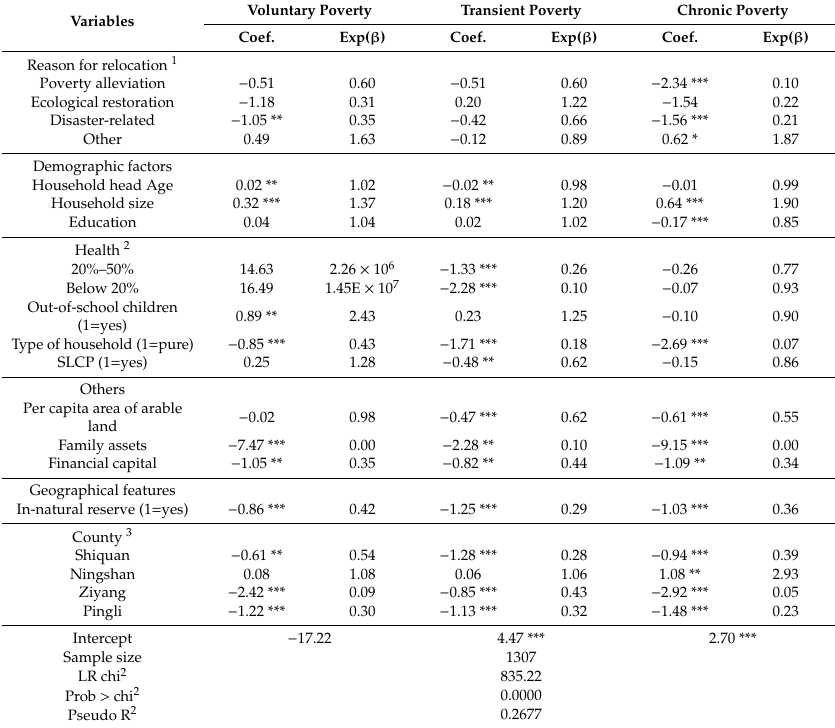
Table 4. Multinomial logistic model regression results of reason for relocation. Variables